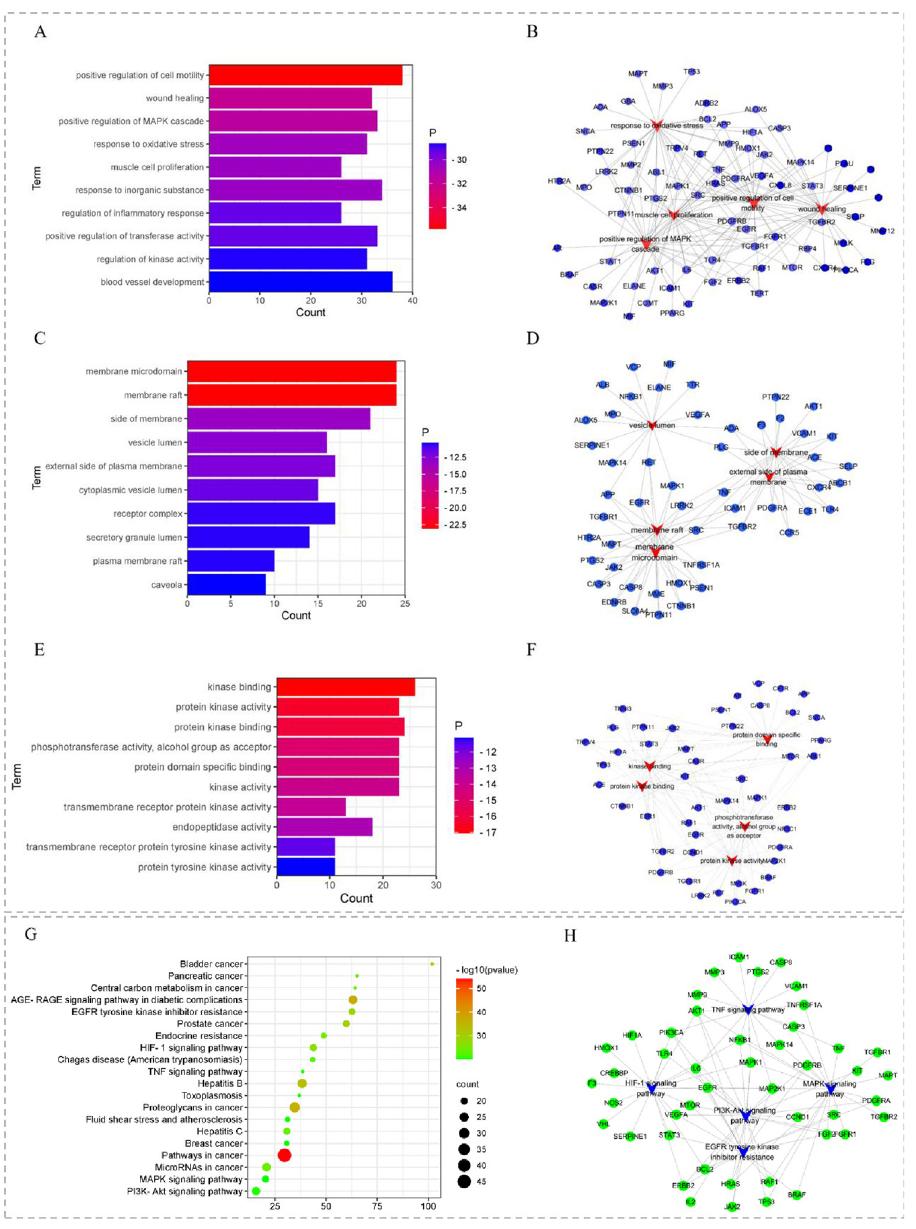
Fig 4. GO and KEGG enrichment of potential targets. (A, C, E: Top 10 significantly enriched terms in BP, CC and MF, respectively. B, D, F: The top five terms and corresponding targets in BP, CC and MF, respectively). (G) Top 20 pathways enriched. (H) Pathway-target network (the five COPD-related pathway and corresponding targets). comprised 190 nodes and 1042 edges. The rectangle nodes represent 105 components identi- fied in AJH, the triangle nodes represent 65 COPD-related targets, and the diamond nodes represent the top 20 enriched pathways. The edges represent interactions between compounds, targets and pathways. According to the topological parameters, 41 hub components were obtained, including 12 flavonoids, 11 steroids, 7 carboxylic acids, 6 terpenes, 2 phenylpropa- noids, 1 quinone, 1 ketone and 1 phenol. The detailed information of components with degree values in the top twenty are shown in Table 1. Among them, Hydroxygenkwanin, luteolin,